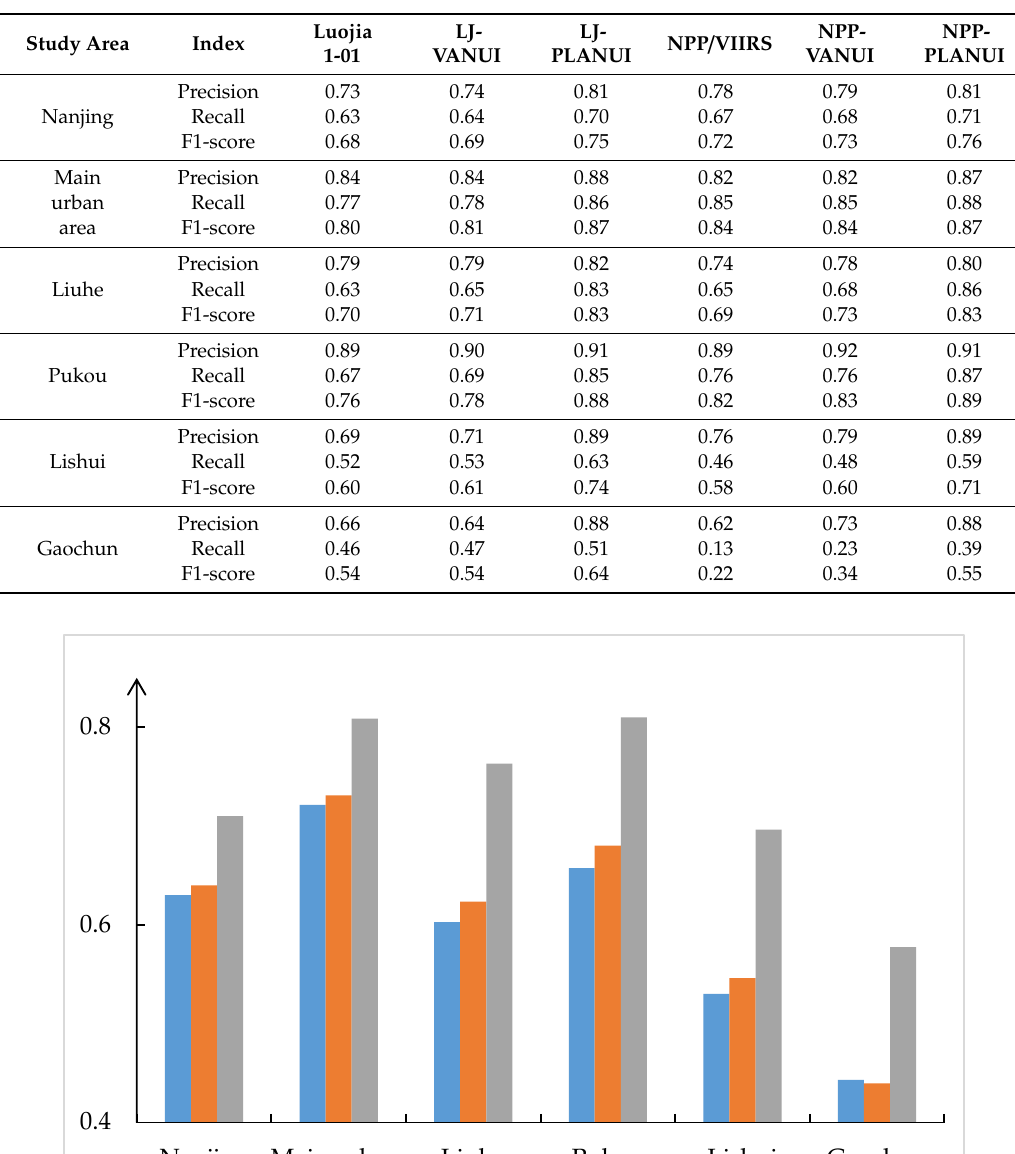
Table 2. Accuracy assessment on the extraction results.